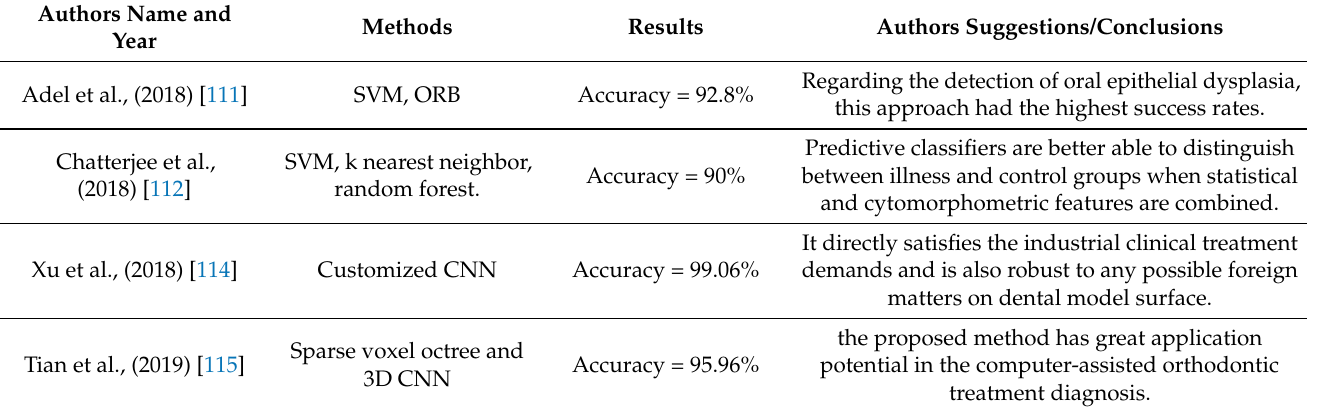
Table 8. CAD–CAM selected studies.